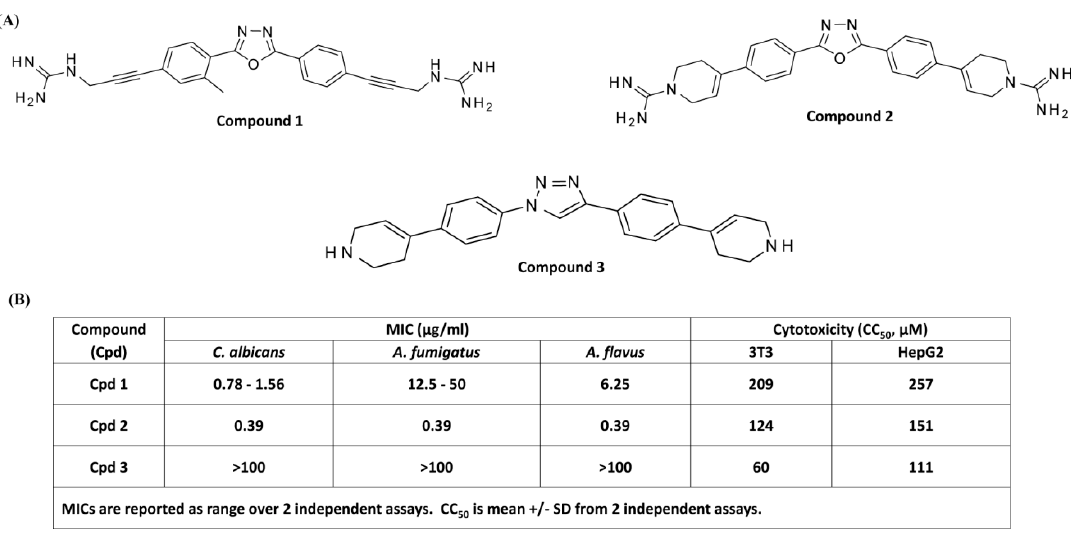
Figure 1. Structure and antifungal activity of three smHDPMs compounds (Cpd). ( A ) Structure of Cpd 1, Cpd 2, and Cpd 3. ( B ) Minimum inhibitory concentration (MIC) values ( µ g / mL) of smHDPMs against C. albicans, A. fumigatus, and A. flavus. Cytotoxicity of smHDPMs on 3T3 and HepG2 cell lines. CC 50; concentration of drug that reduces 50% cell viability.